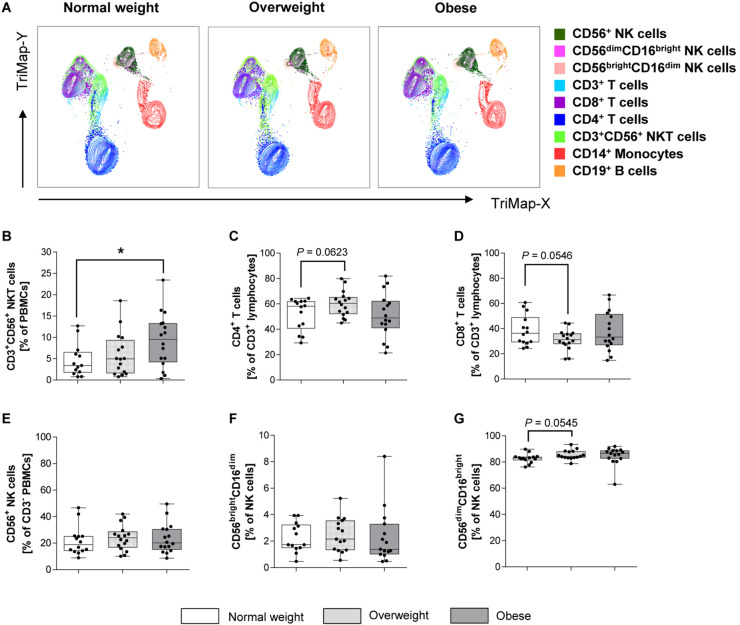
Frequencies of immune cell populations in peripheral blood mononuclear cells (PBMCs) isolated from normal weight (n = 14), overweight (n = 16), and obese (n = 16) healthy blood donors. (A) TriMap plots are presented showing the combined clusters of all donors subdivided into normal weight, overweight and obese. Clusters were identified by manual gating using the surface marker indicated on the legend. Percentage of CD3+CD56+ natural killer T (NKT) cells (B) within viable PBMCs. CD4+ helper T lymphocytes (C) and CD8+ cytotoxic T lymphocytes (D) as percentages of CD3+ T lymphocytes. Percentage of CD56+ NK cells in CD3– cells (E). Percentage of CD56brightCD16dim NK cells (E) and CD56dimCD16bright NK cells (G) in NK cells. (B–G) Graphs are box and whisker plots with median ± minimum to maximum value; with additional dot plot representing individual donors. Overweight and obese groups were compared to normal weight control group. Statistical significance is indicated as: *P ≤ 0.05; exact P-values within 0.05 ≤ P ≤ 0.1 are indicated.